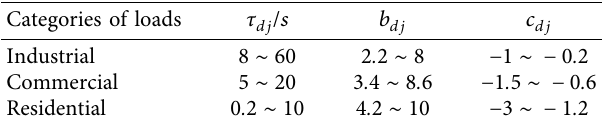
Table 2: Parameters of consumption